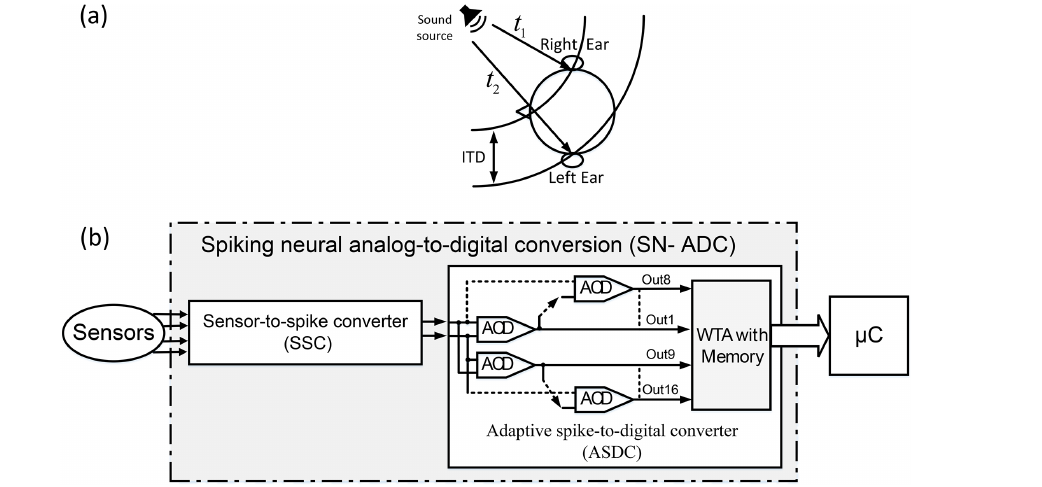
Figure 1. (a) Acoustic localization model. The brain uses the interaural time differences (ITDs) between the two signals arriving at the ears, t 1 − t 2 , to locate the voice’s position, where t 2 and t 1 are the times of the voice arriving at the left and right, respectively. (b) Neuromorphic signal conditioning architecture. Sensor-to-spike conversion (SSC) transfers the sensor signal into two spikes at different times, depending on the sensor signal. The adaptive spike-to-digital converter (ASDC) block generates digital code based on this time difference between the spikes. The ASDC has two main blocks, namely adaptive coincidence detection (ACD) and winner-take-all (WTA), with